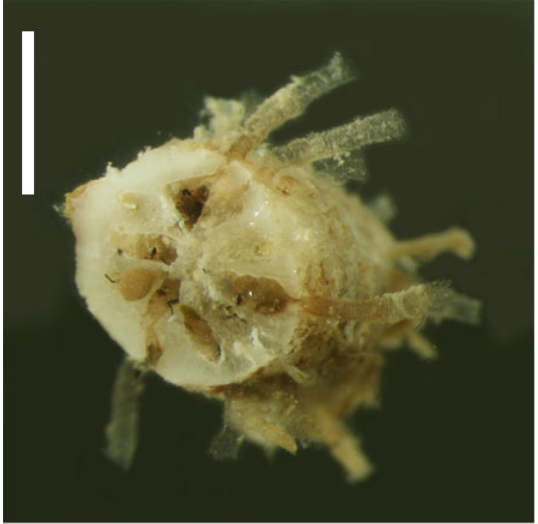
Figure 1. Transversal section of the bryozoan Myriapora truncata colonized by Rhabdopleura recondita . Erect semi-transparent tubes of R. recondita project from the bryozoan host zoarium. Scale bar 2 mm.